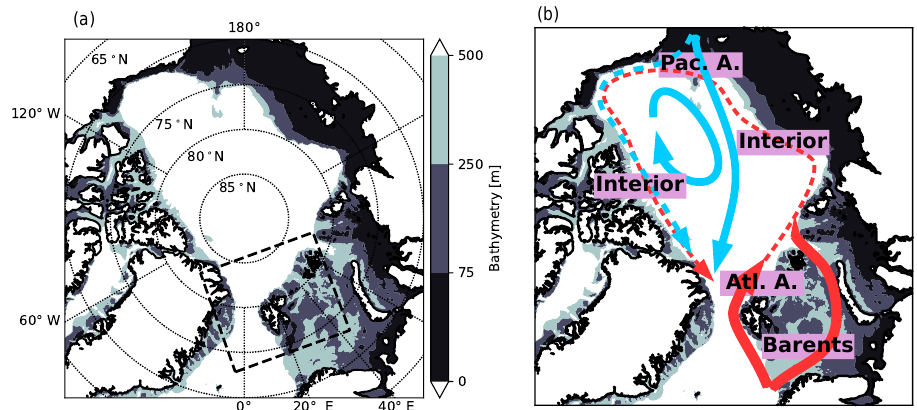
Figure 1. Map of the Arctic Ocean (based on Jakobsson et al., 2012) indicating the general geographic regimes. (a) Bathymetry of the shelf and shelf break area. The box in dashed lines shows the area in Fig. 4a. (b) The Pacific Arctic, Atlantic Arctic, interior shelves (following Williams and Carmack, 2015) and the Barents Sea. Arrows show selected patterns of the general circulation (after Polyakov et al., 2012). Blue arrows: Pacific-derived and other fresh water flowing along the shelf break through the Transpolar Drift and in the Beaufort Gyre. Red arrows: Atlantic-derived water entering the Arctic Ocean through the Fram Strait and the Barents Sea, submerging north of the Barents Sea and recirculating along the shelf break through the Arctic Ocean. Other major currents are not indicated here as they are of minor importance to this paper.